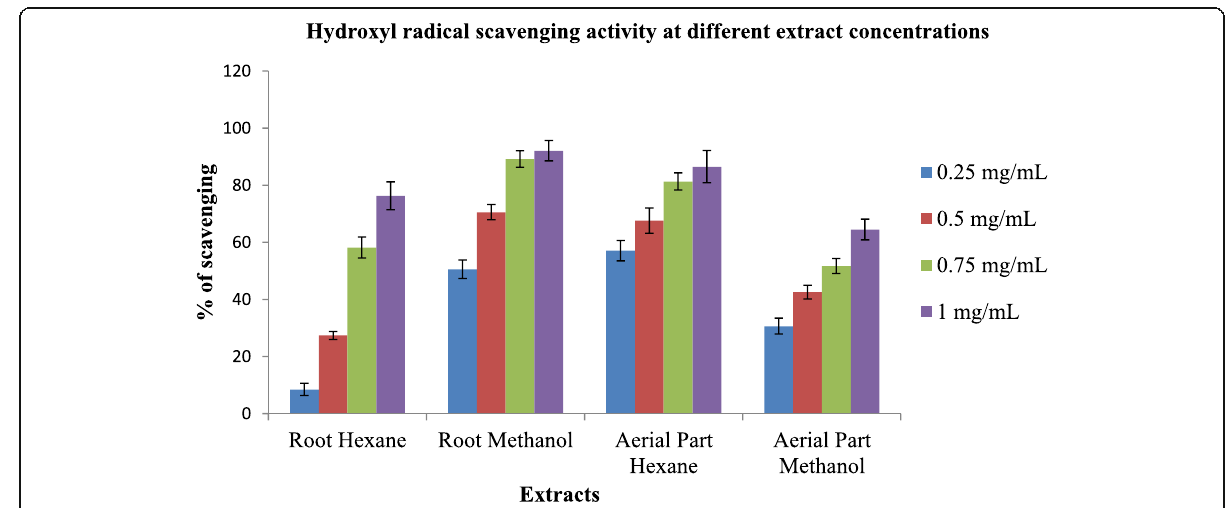
Fig. 3 Hydroxyl radical scavenging activity of different extracts of V . coriaceum at different concentrations